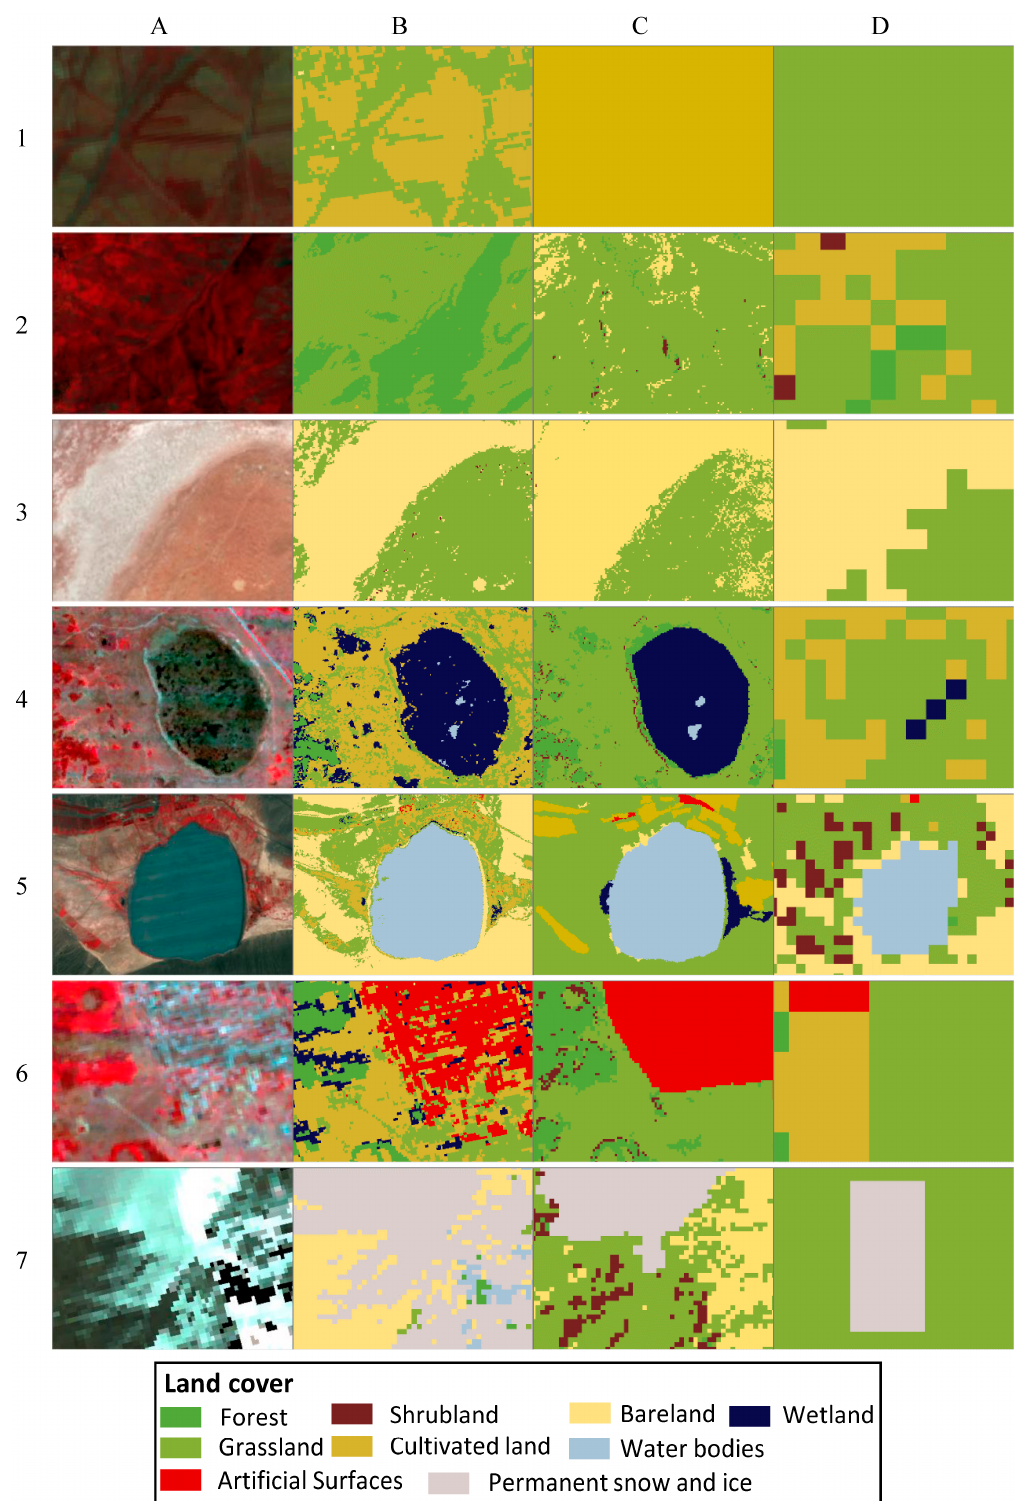
Figure 4. Comparison of different land cover products in 2010. ( A ) Landsat annual median TOA false color composition in 2010 (RGB: B4, B3, B2), ( B ) this product, ( C ) GlobeLand30, and ( D ) MCD12Q1 product. Comparison of cultivated land, forests, grassland, bareland, wetland, water bodies, artificial surfaces, permanent snow and ice from 1 to 7.